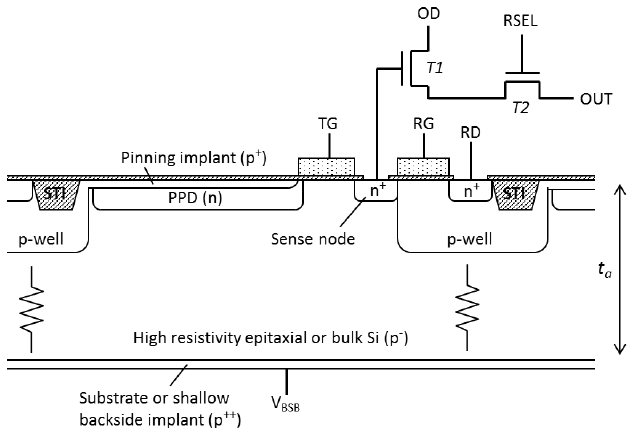
Figure 1. Cross section of a typical pinned photodiode (PPD) pixel showing the conductive path from the front-side p-wells to the p ++ substrate (for front-side illuminated devices), or to the shallow p ++ back side implant (for back-side illuminated devices). The transistors T1 and T2 are physically located in the